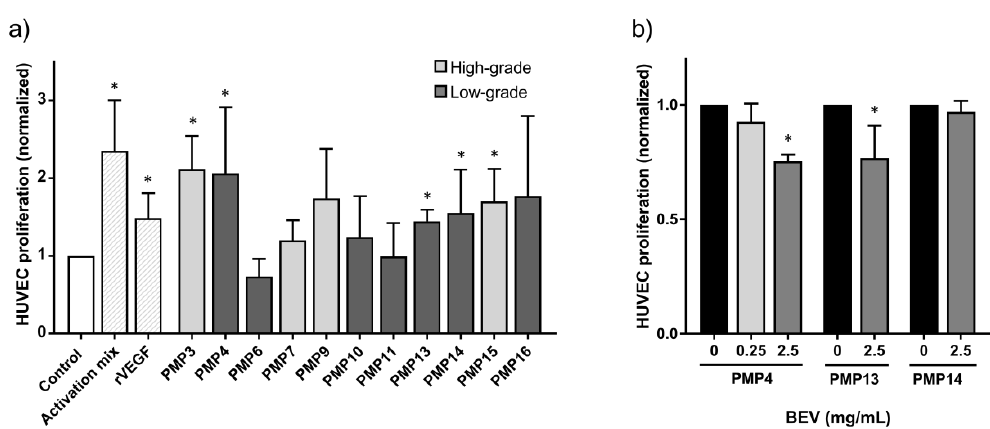
Figure 2. Proliferation of human umbilical cord vascular endothelial cells (HUVEC). Error bars indicate standard deviation. *, p ≤ 0.05. ( a ) proliferation measured after incubation with activation mix, recombinant VEGFA (rVEGF, 250 ng/mL) or tumor samples from patients with pseudomyxoma peritonei (PMP) compared to control medium. Light grey bars indicate high-grade, while dark grey indicate low-grade patient samples. ( b ) the proliferative response of HUVEC incubated with the PMP4, PMP13 and PMP14 tumor sample with and without addition of anti-angiogenic drug bevacizumab (BEV, 0.25 or 2.5 mg/mL).